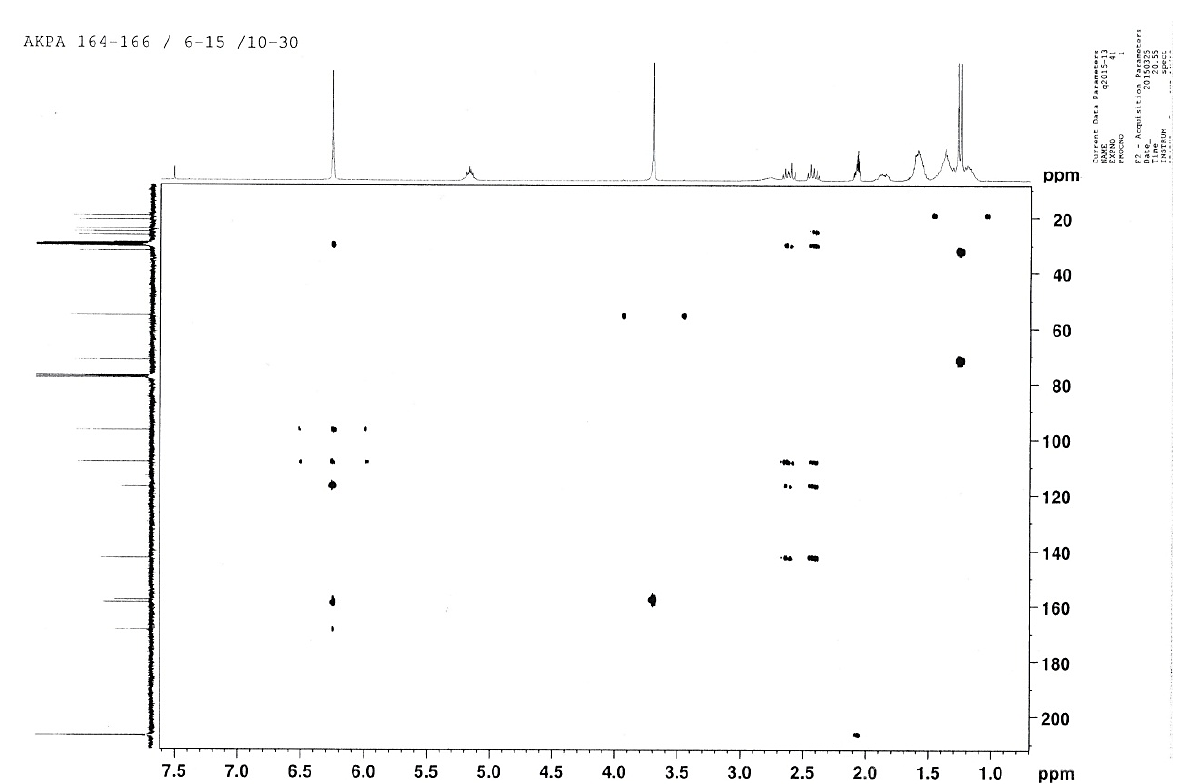
Figure A5. HMQC spectrum of isolated compound